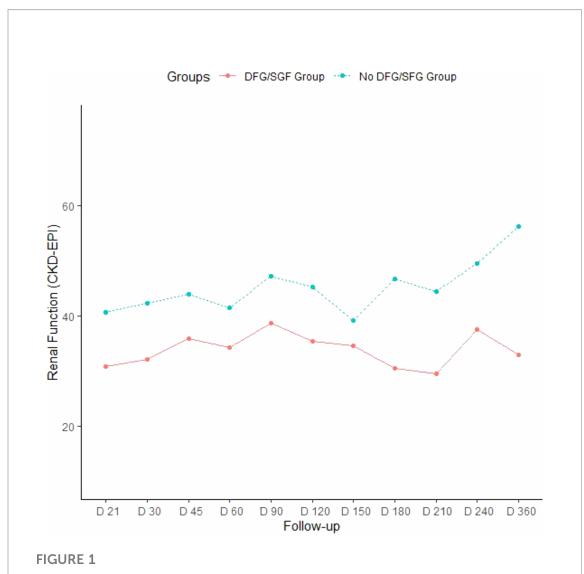
FIGURE 1 Evolution of renal function according to the occurrence of early ECD transplant dysfunction 7 days post-transplant surgery eGFR (mL/min/1.73 m 2 ) was analyzed in kidney transplant recipients at different time points (D: days) and notably at two months and 3 months following transplant surgery within the group of the 47 ECD donors (Extended Criteria Donors), further strati fi ed according to the occurrence or delayed or slow graft dysfunction during the fi rst week following transplantation (DGF/ SDG group, lower line) or no early graft dysfunction at day 7 (upper dot